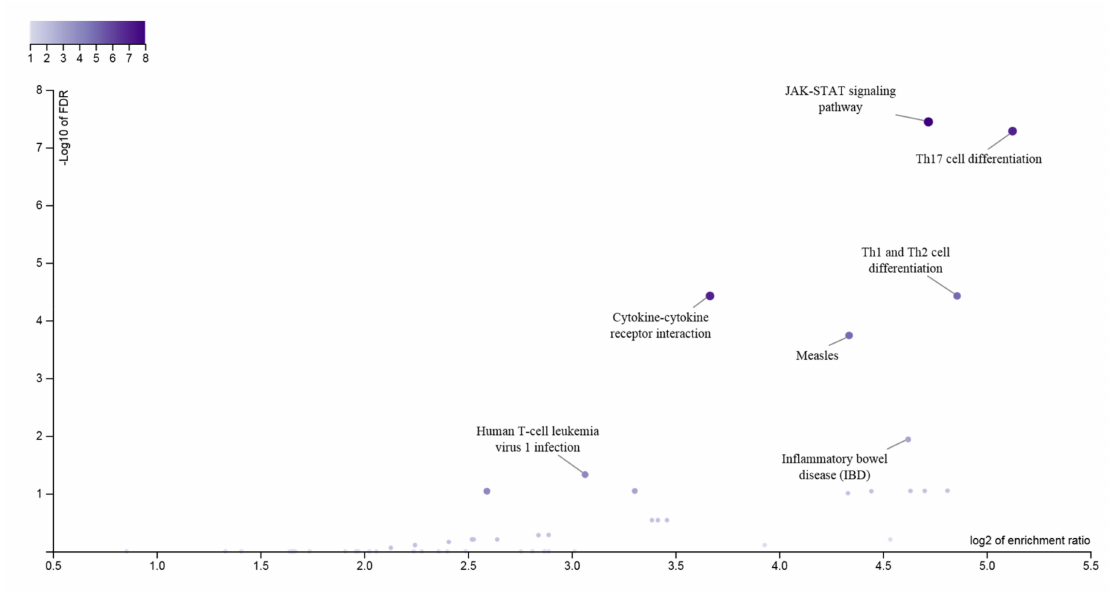
Figure 1. Pathway analysis of 33 genes at the JIA GWAS loci. The enrichment ratio for the functional categories in the KEGG database is shown on the X -axis and the log of the FDR is shown on the Y -axis, indicating the degree by which the significant categories stand out from the background. The size and color of the dot are proportional to the number of input genes falling into each pathway.